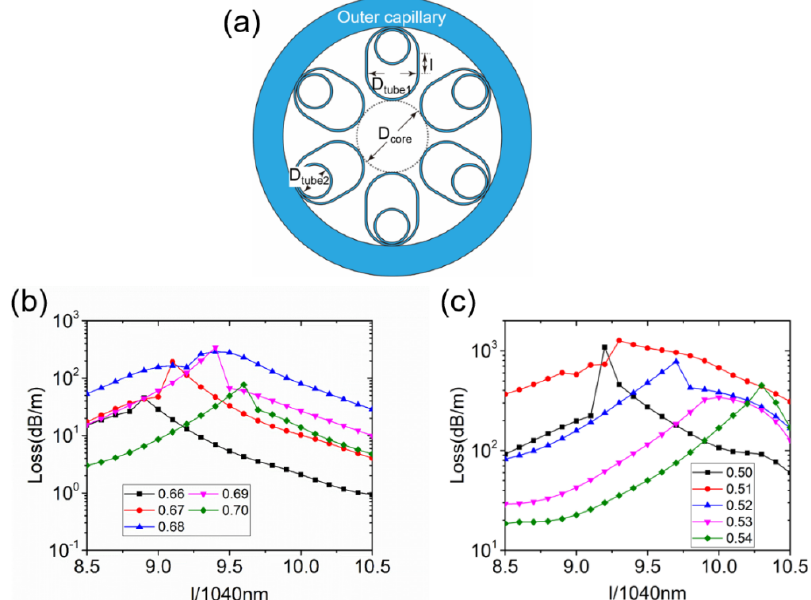
Figure 7. ( a ) Geometry of the NANF with extended cladding tubes. ( b ) The LP 11 mode loss in the NANF with extended cladding tubes as a function of l when D tube2 / D core = 0.66, 0.67, 0.68, 0.69,